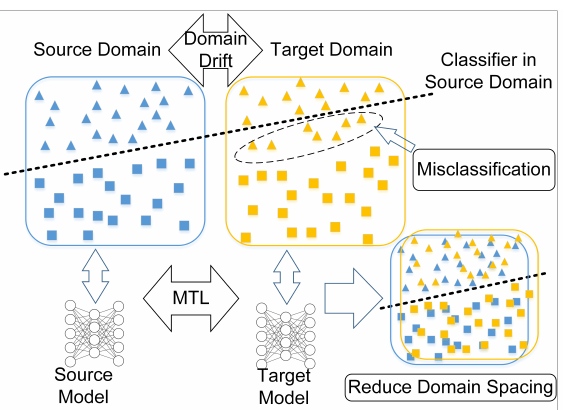
Figure 4. Transfer learning in cluster networks, where multi-task learning is